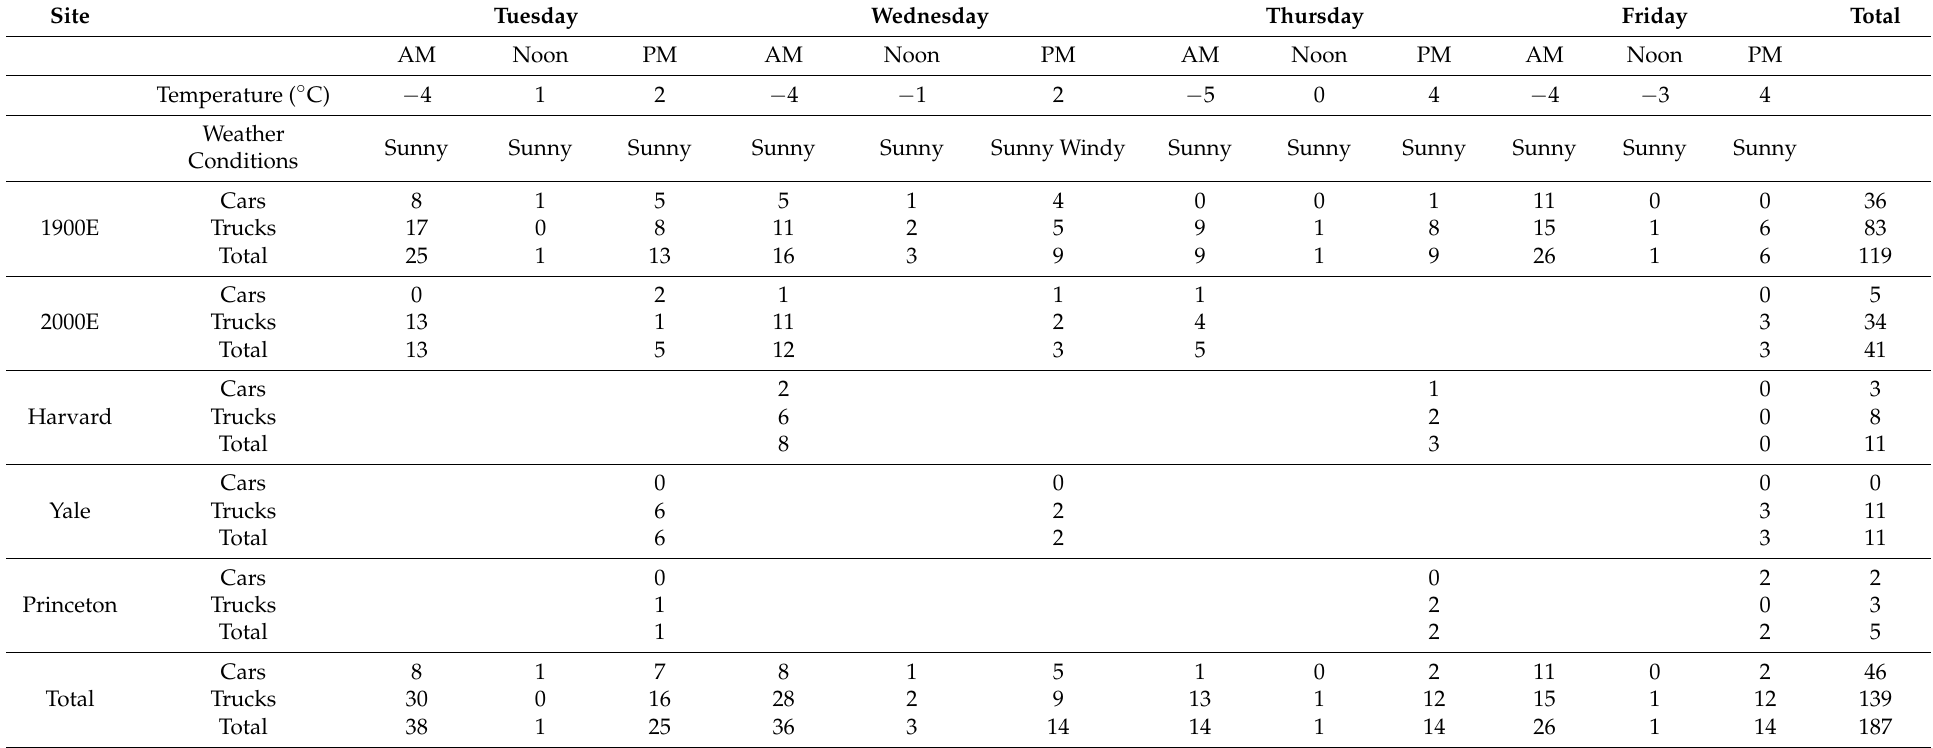
Table 7. Idling vehicle counts during the post-intervention week: 18–21 February